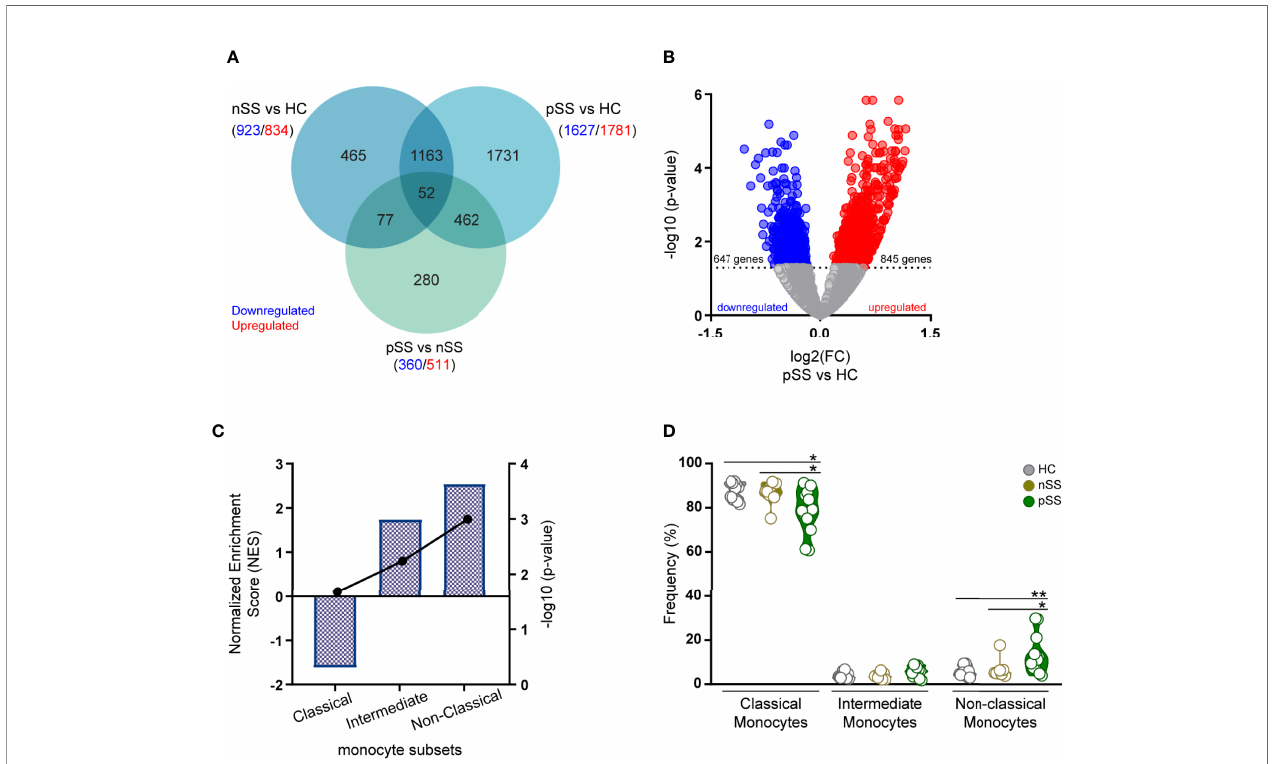
FIGURE 1 | Transcriptomic pro fi le of monocytes from pSS patients is enriched for genes associated with intermediate and non-classical monocytes. RNA sequencing of peripheral blood isolated monocytes of nSS and pSS patients and HC was performed and differentially expressed genes (DEGs) were identi fi ed. Venn diagram shows the overlap of the DEGs between the different comparisons with a nominal p-value < 0.05, downregulated (blue) or upregulated (red) genes are indicated for each comparison (A) . The relationship between the fold change (log2) and the corrected p-value (-log10) of the DEGs in pSS vs. HC is displayed. DEGs, with a corrected p-value < 0.05, downregulated (blue) or upregulated (red) in pSS-monocytes are indicated (B) . Gene-set enrichment analysis was performed comparing the DEGs identi fi ed in pSS patients to the molecular signature of the different monocyte subsets. Columns and left y-axis show the normalized enrichment score, black connected dots and right y-axis displays the FDR-corrected p-value (-log10) (C) . Frequency of monocyte subsets assessed by fl ow-cytometry in HC, nSS and pSS patients after cell isolation is shown (D) . * and ** represent p < 0.05 and p < 0.01,